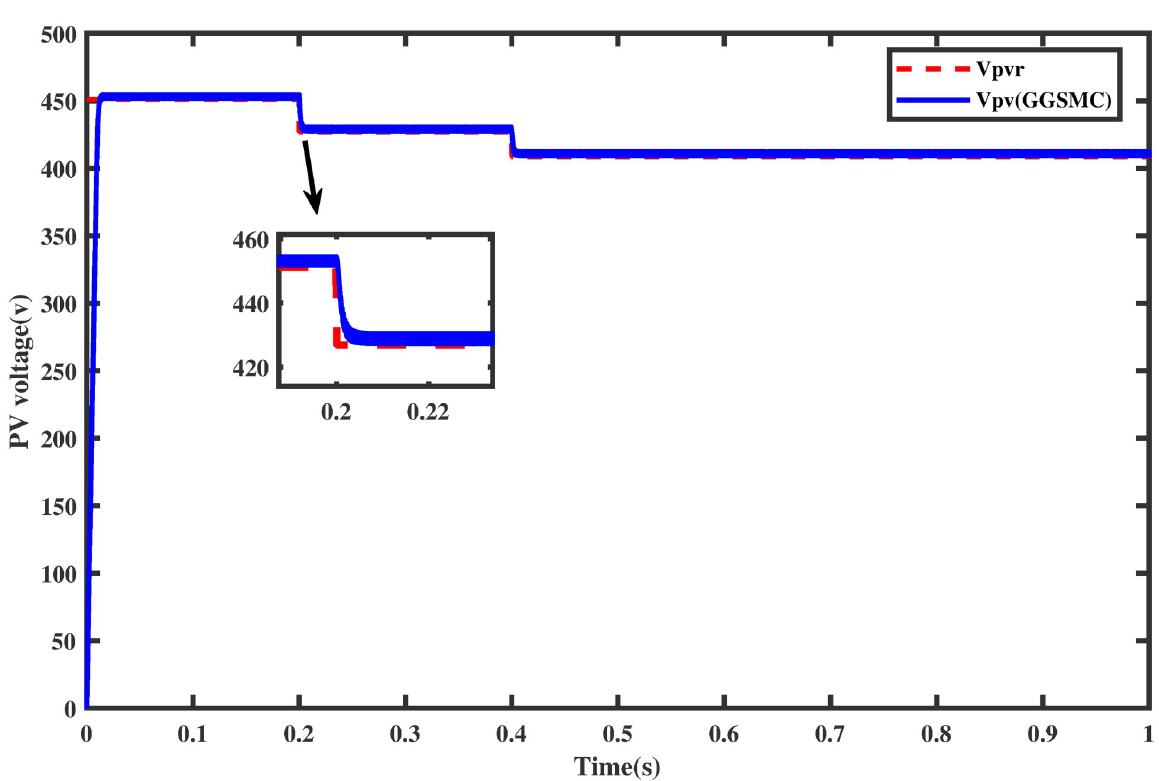
Fig 13. Tracking of V